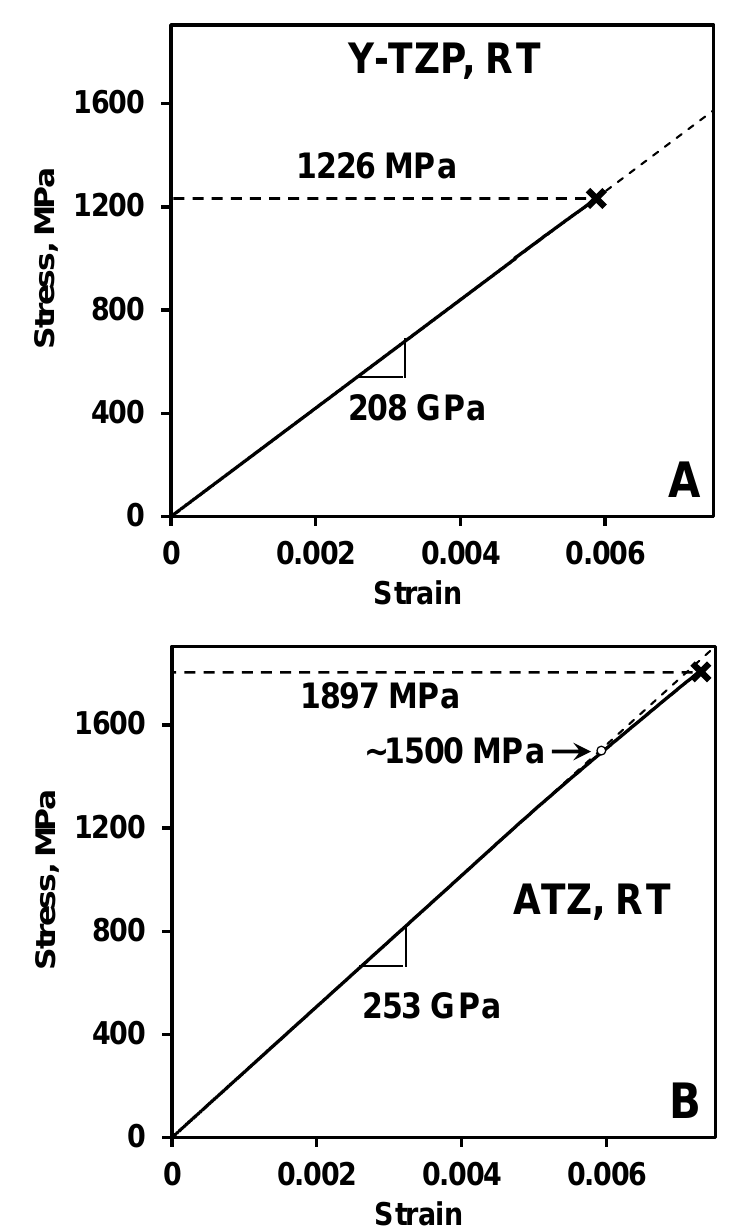
Figure 8. Stress-strain diagrams of Y-TZP ( A ) and ATZ ( B ), where a strain was reconstructed from a crosshead displacement and compliance of a universal testing machine using known Young’s moduli of the ceramics under loading.